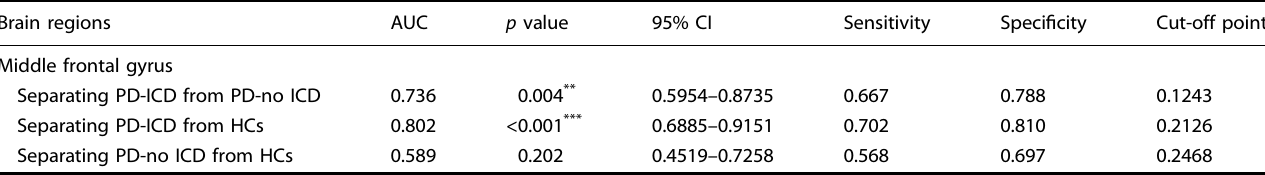
Table 3. ROC analyses for differentiating different